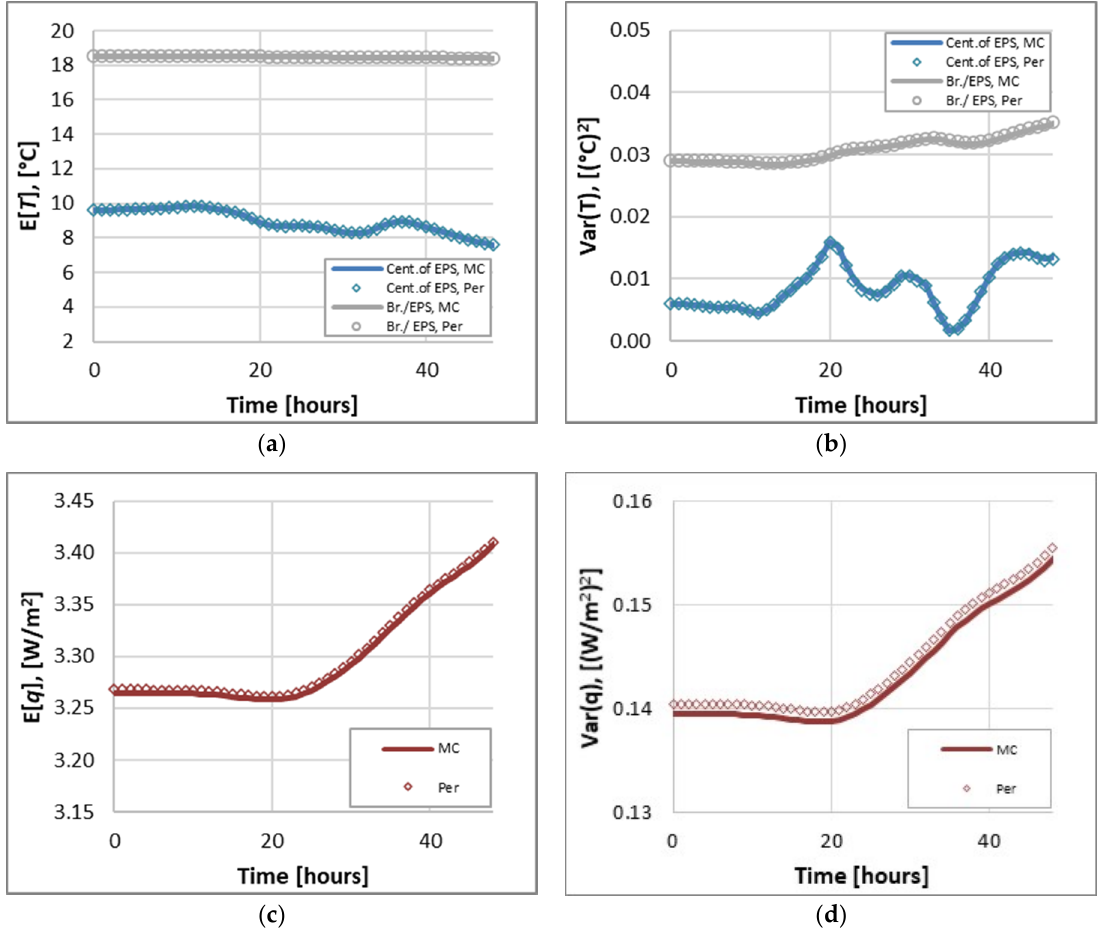
Figure 4. Comparison of ( a ) the expected values and ( b ) variance of temperature in Point 3 (“Br./EPS”) and Point 4 (“Cent.of EPS”) and ( c ) expected values and ( d ) variance of heat flux using the Monte Carlo method (“MC”) and the perturbation method (“Per”) during the first 48 h of the calculations for Case 1.